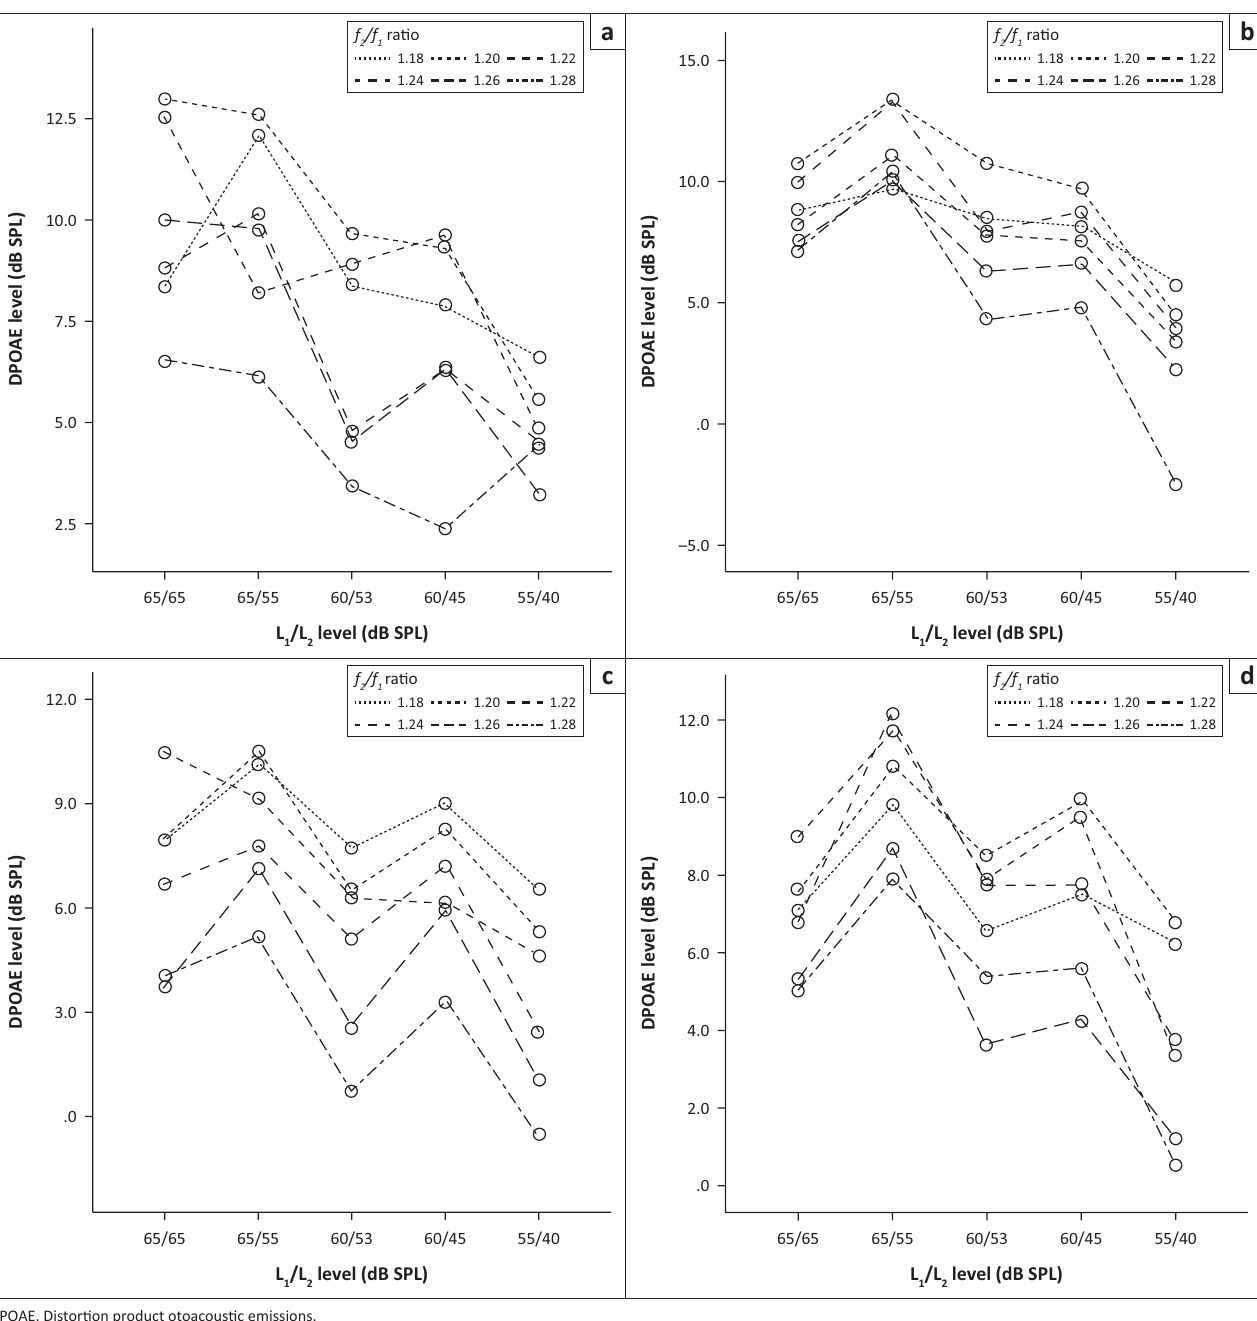
): (a) right ear at 2003 Hz, 2